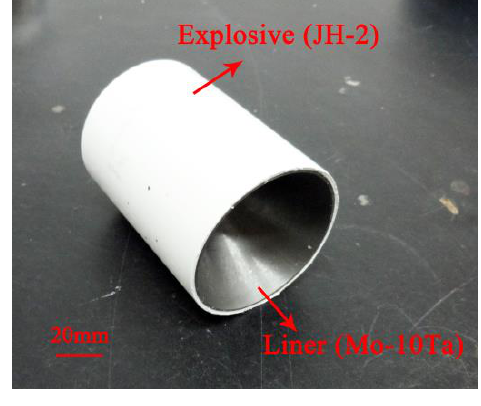
Figure 5. SCJ Warhead.